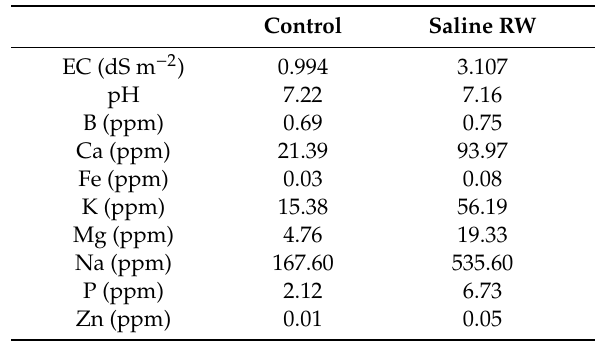
Table 1. Physicochemical analysis of the irrigation water. Data are values from samples collected at the beginning of the